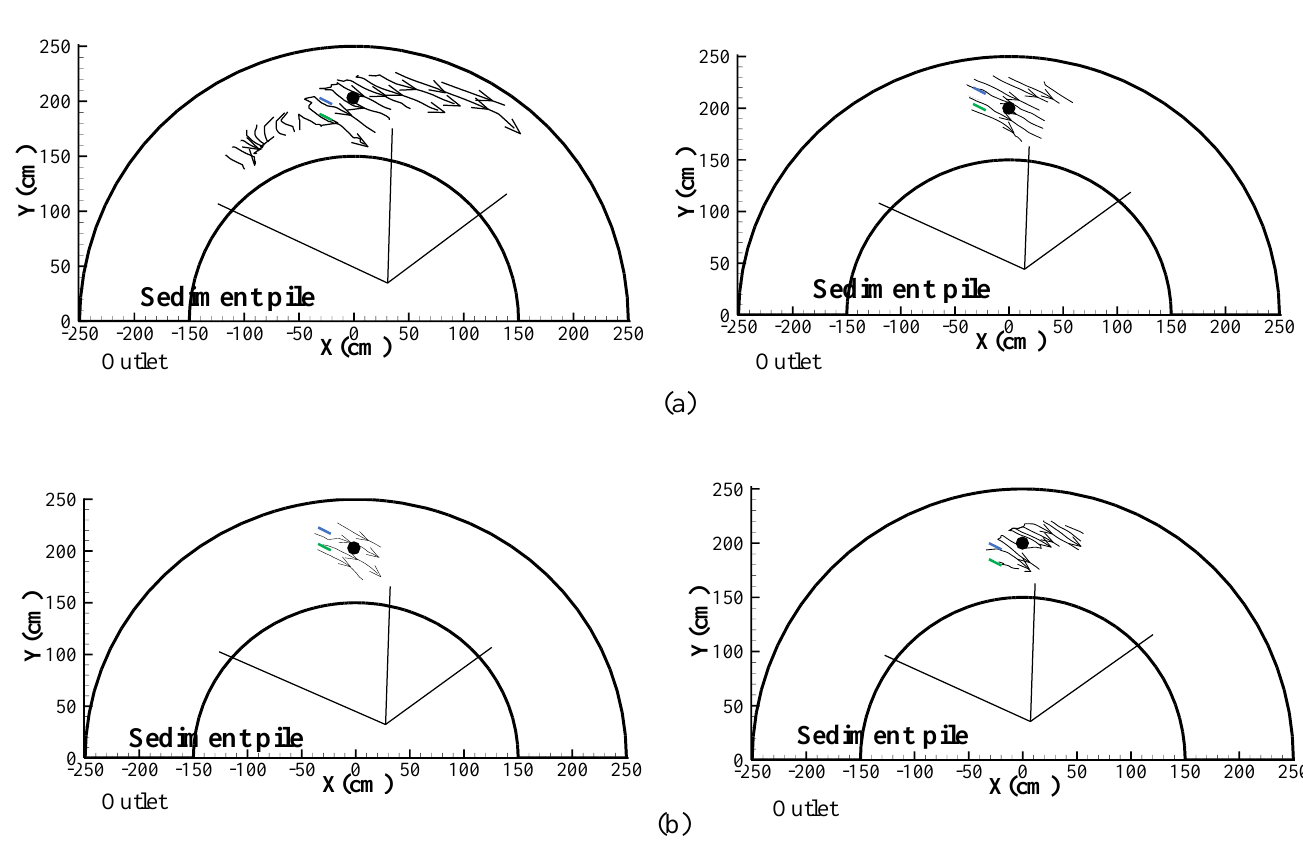
Figure 10. The diagram on streamlines at levels equal to a) 20, and b) 30% of the flow depth at the beginning of the bend, lower than the bed. (PFV experiment on the right, and PSV experiment on the